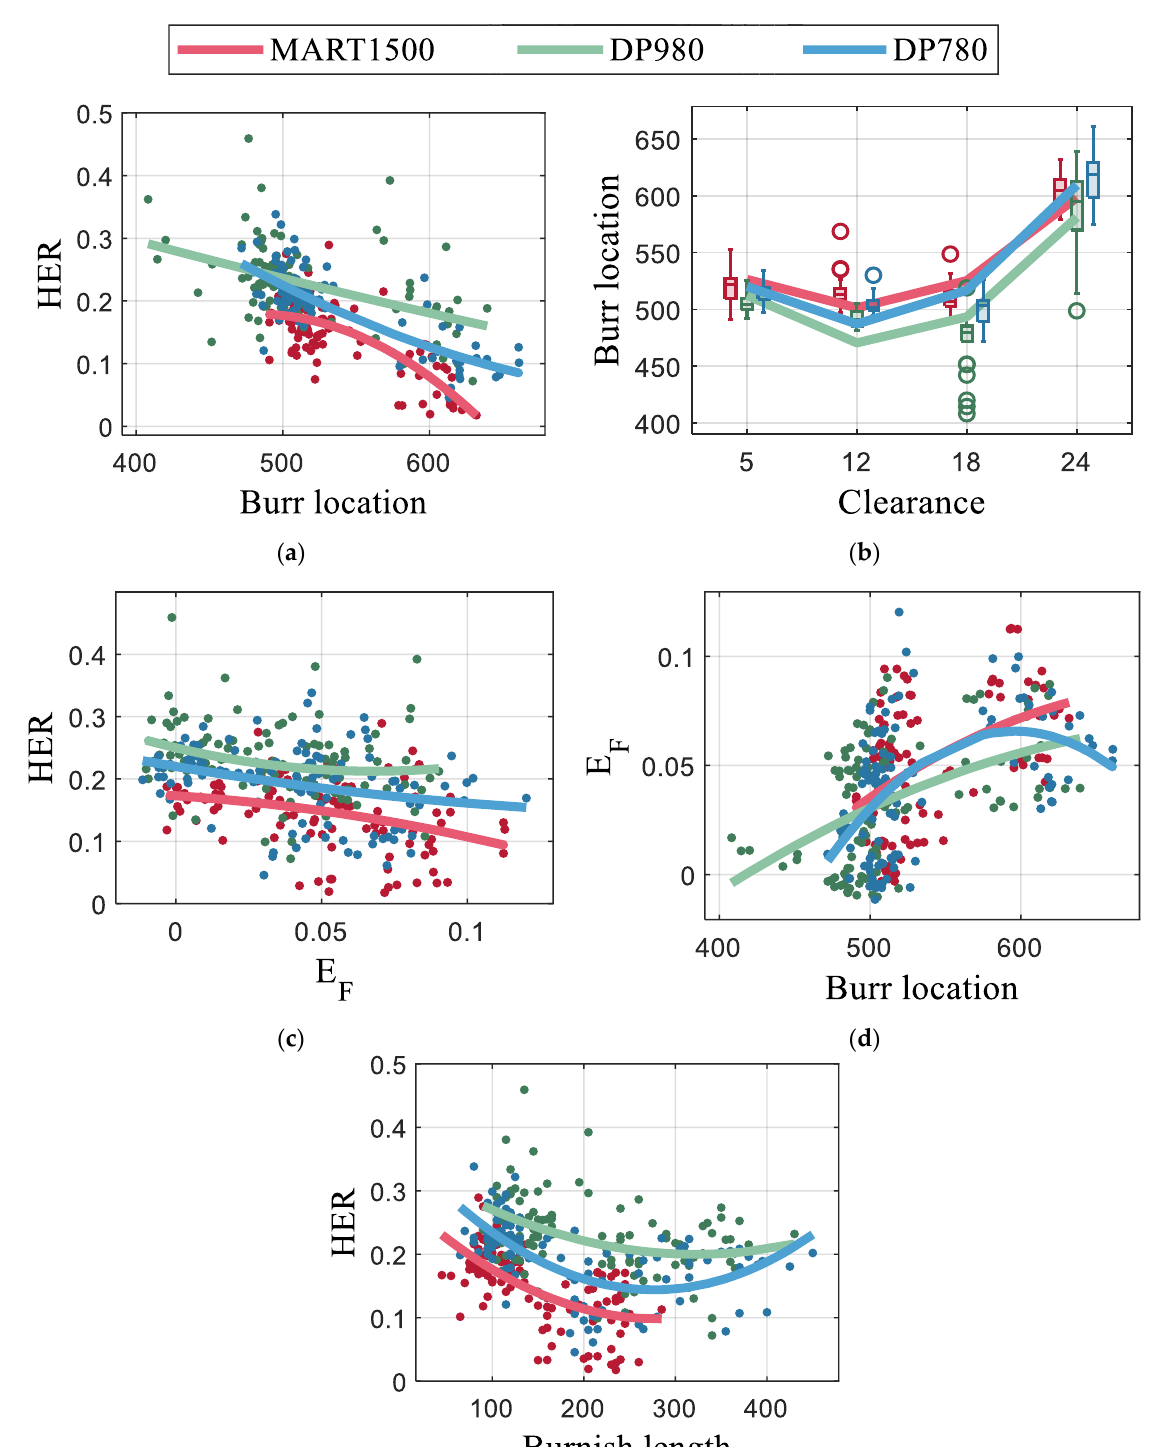
Figure 16. Effects of features: relation of burr to ( a ) HER and ( b ) clearance; relation of punch load to ( c ) HER and ( d ) burr; and relation of burnish length to ( e ) HER. It was observed that the HER increased with decreasing load energy 𝐸 𝐹 (Figure 16c).